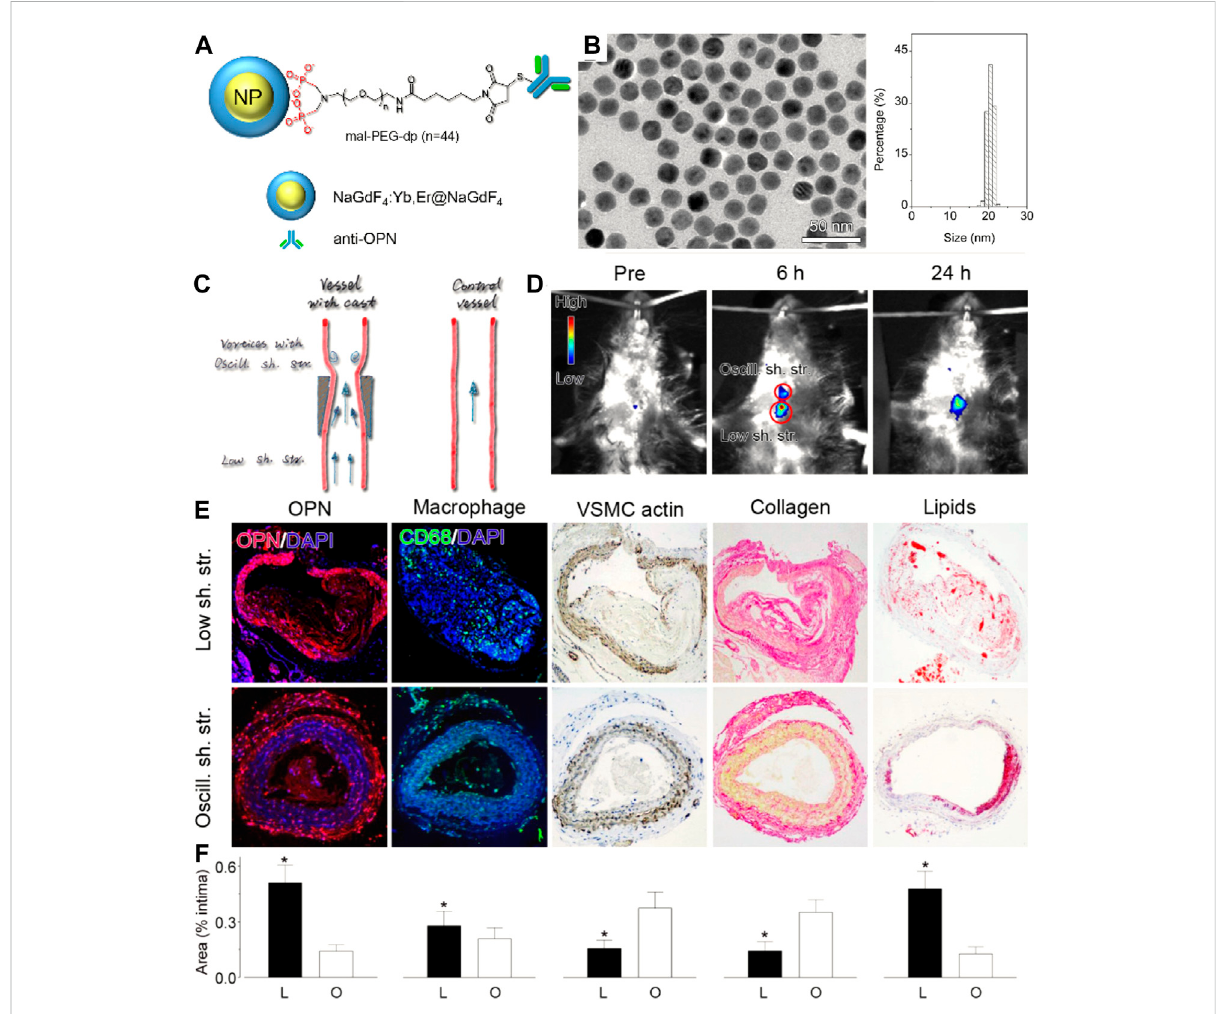
FIGURE 9 (A) Schematic diagram and (B) TEM images and size histograms of the UCNP-anti-OPN probe. (C) Schematic diagram for showing the varied stress-induced plagues in ApoE − / − mice. (D) In vivo upconversion luminescent images captured before and at different time points after